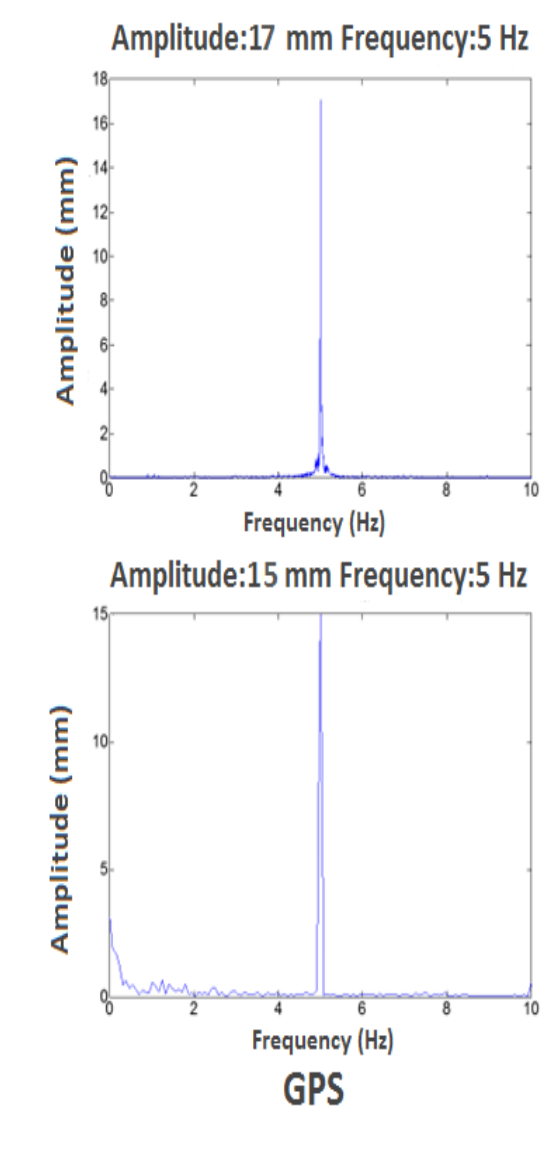
Figure 5. FKP Method Comparison of LVDT and GPS Frequency-Amplitude